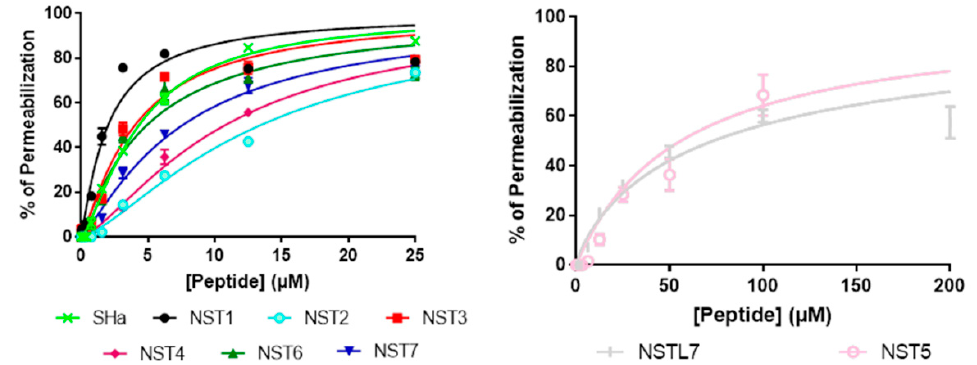
Figure 2. Time-dependent effect of temporin-SHa and its analogs on the membrane integrity of H. pylori. H. pylori (ATCC 43504) was exposed to temporin-SHa or its analogs at five times their MIC. Kinetics of changes in fluorescent signal (excitation at 530 nm and emission at 590 nm) corresponding to membrane permeabilization and propidium iodide cell entry were measured over 60 min of incubation at 37 ◦ C in micro-aerobic condition. Results are expressed as percentage of membrane permeabilization using CTAB (cetyl-trimethylammonium bromide) at 300 µ M as positive control giving 100% permeabilization. Results corresponding to means ± SD ( n = 3) were fitted using the Graph Pad Prism software.